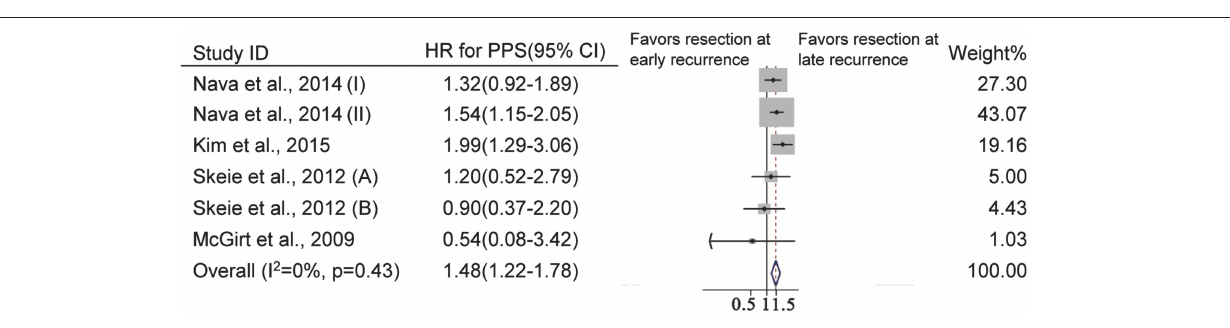
FIGURE 5 | Forest plots for post-progression survival analysis when accounting for vs. not accounting for the time to first recurrence.